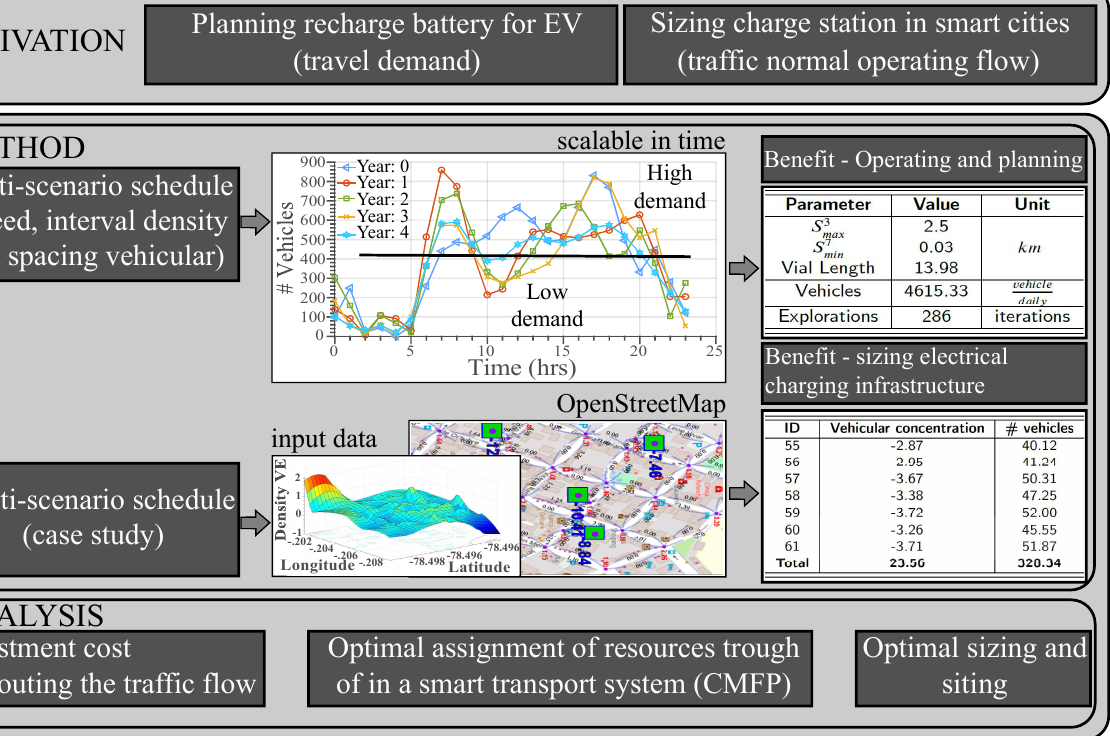
Figure 1. Proposed architecture for the deployment of electric charging